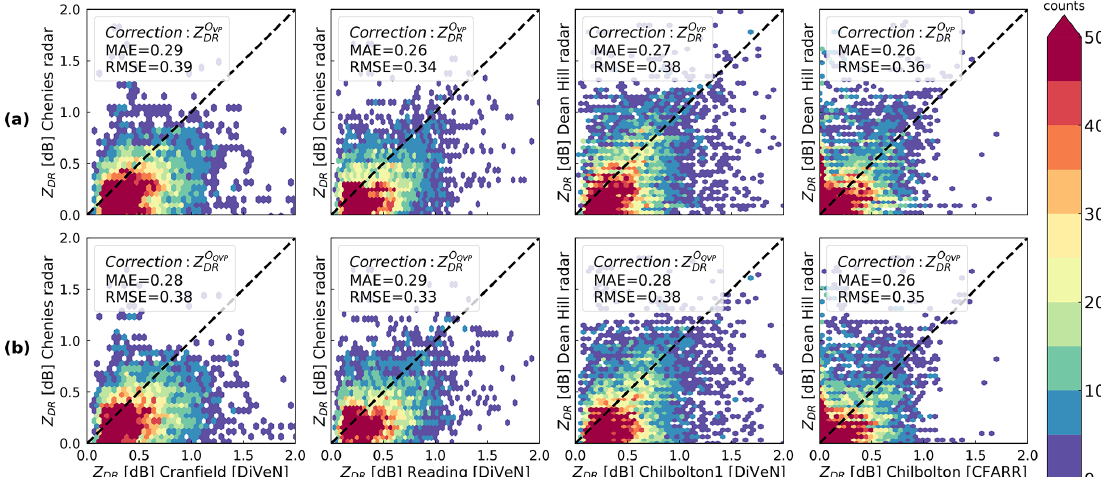
Figure 9. Scatterplots between radar and disdrometer Z DR measurements at several locations: panel (a) shows scatter density plots of Z DR offset-corrected using VPs at two different radar sites versus Z DR derived from disdrometer data; panel (b) shows the same as in (a) , but the radar Z DR measurements are calibrated applying the QVP-based